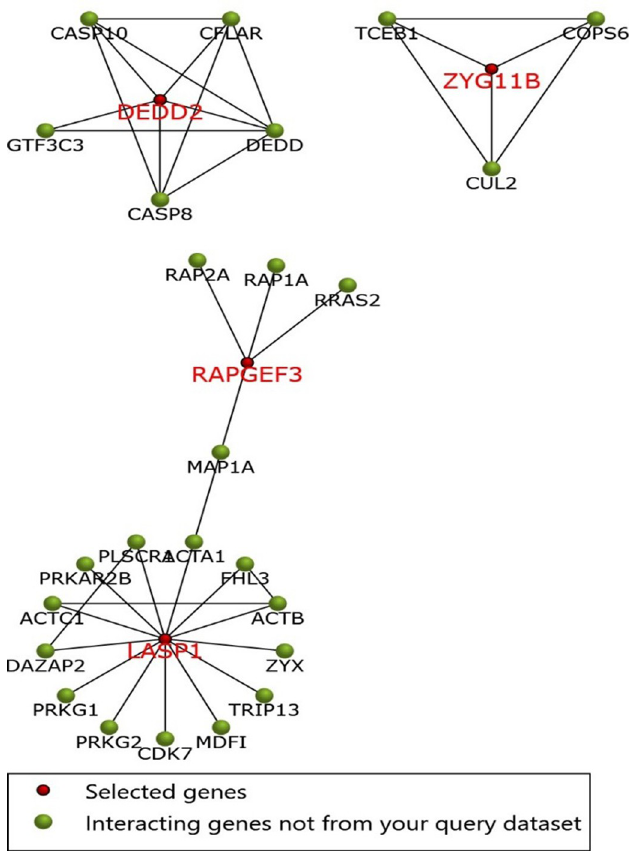
Fig 3. The PPI network of the eight genes, and their related genes, created by the FunRich software. Red nodes represents eight significant genes filtered through gene expression analysis, while green nodes represents neighboring genes of the eight